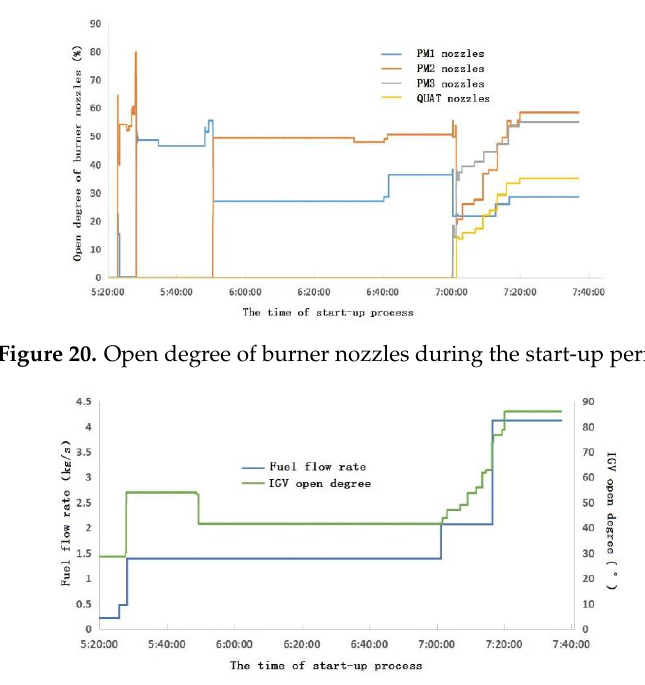
Figure 21. Open degree of inlet guide vanes (IGV) and fuel flow rate during the start-up period.